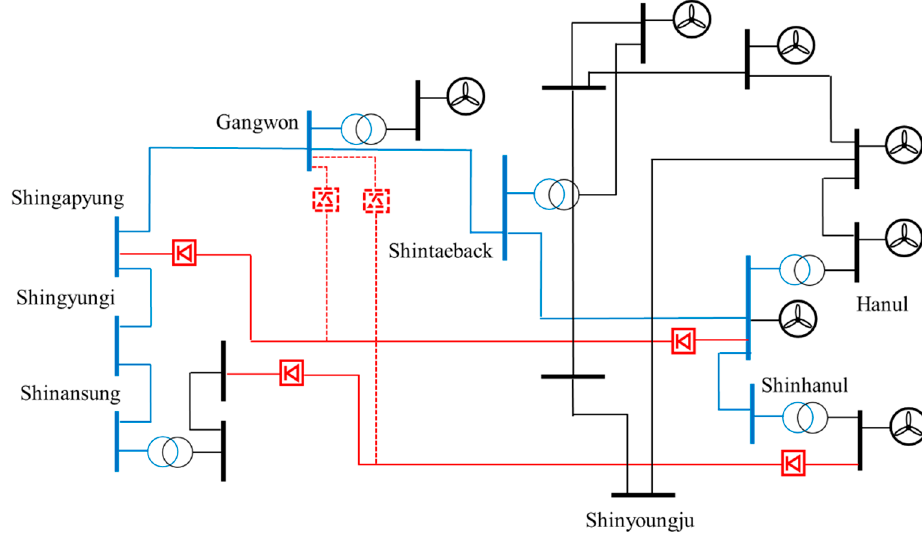
Figure 22. Actual power system data with the hybrid MTDC system.